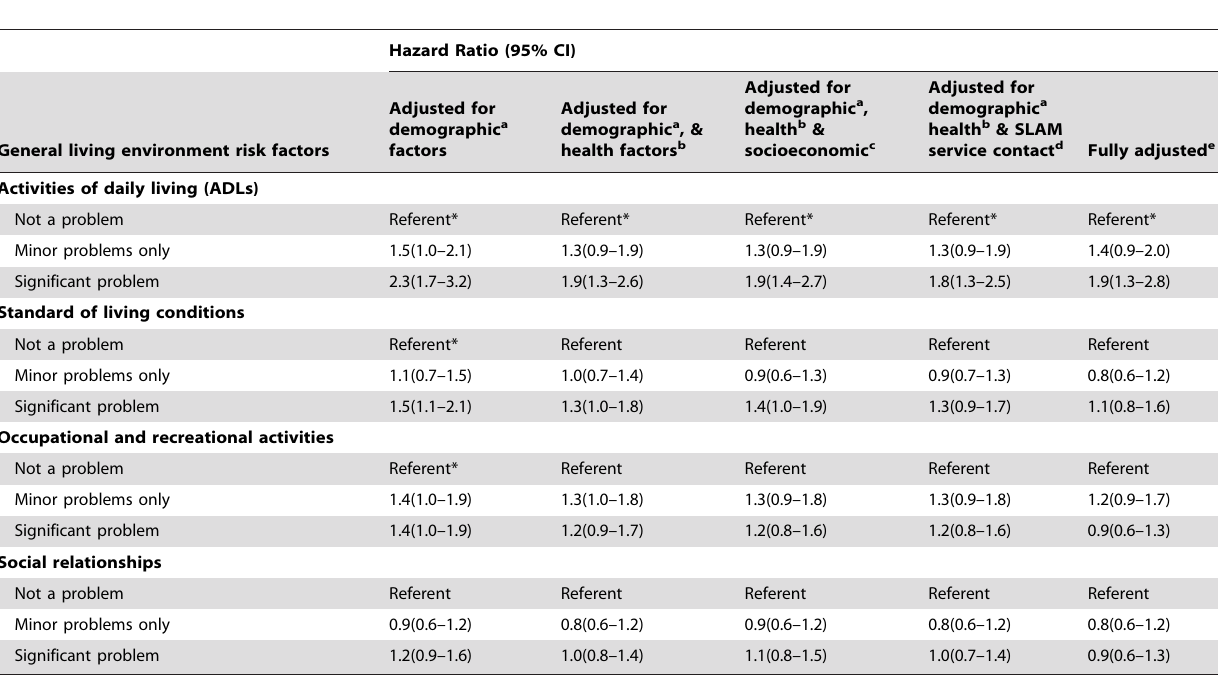
Table 2. Multivariate Cox regression analyses of functional status and environment risk factors for all-cause mortality in individuals with serious mental